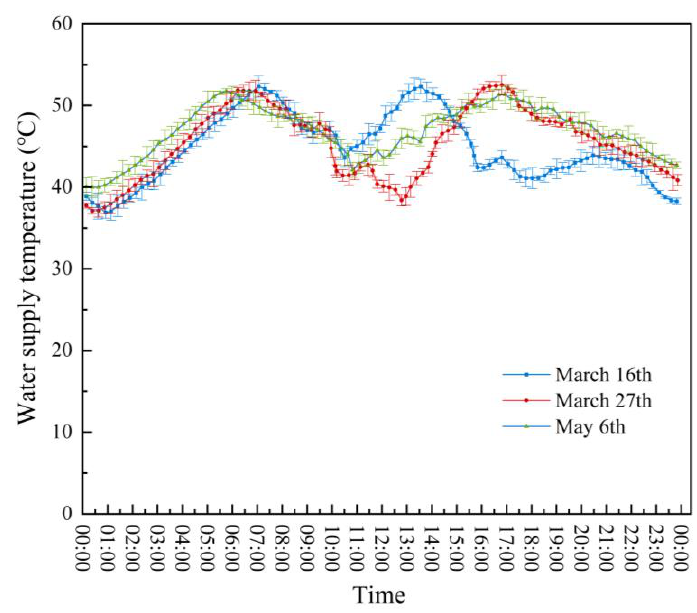
Figure 10. Water supply temperature of the SA-ASHP water heating system.